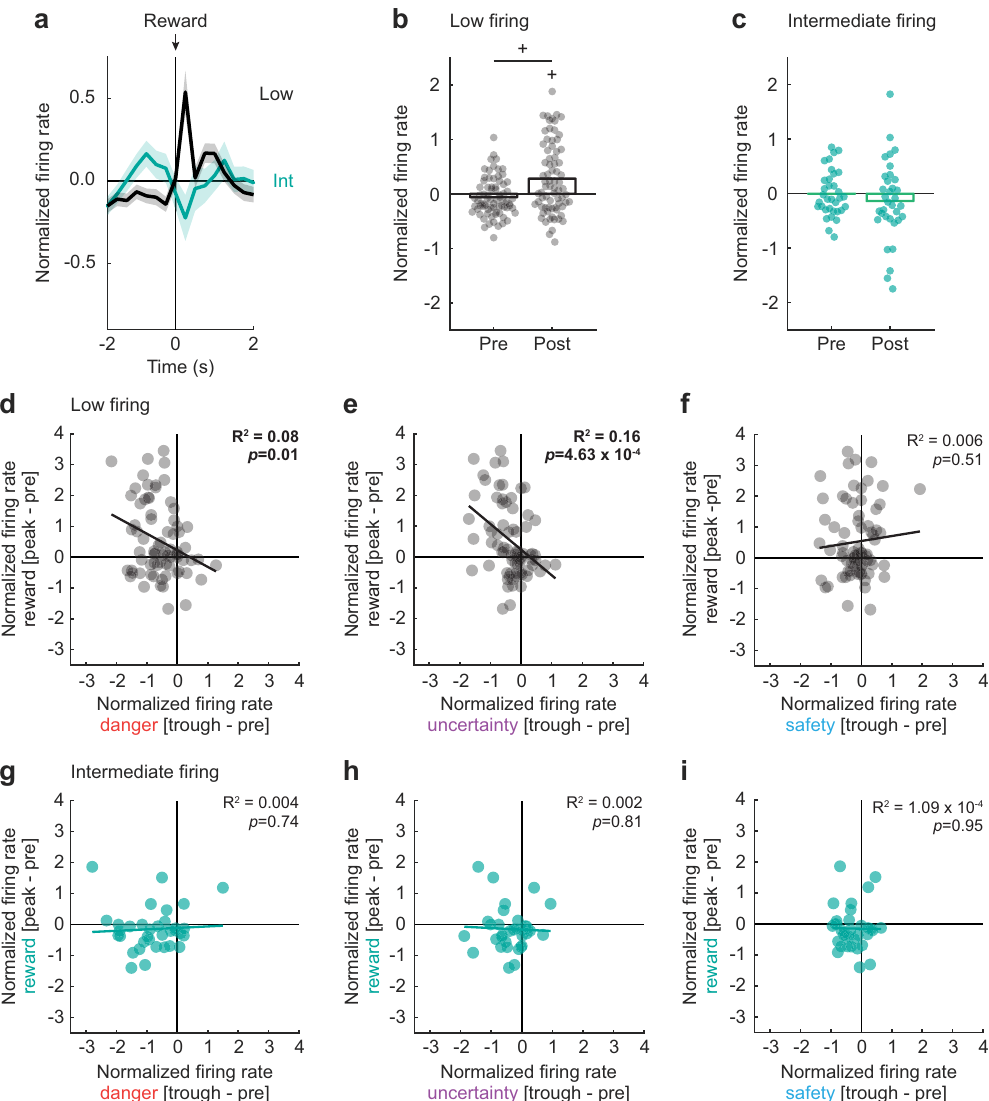
Fig. 5 Low fi ring neurons show opposing responses to threat and reward. a Mean ± SEM normalized fi ring rate to reward is shown 2 s prior to and 2 s after reward delivery (advancement of pellet dispenser) for the Low ( n = 74, black) and Intermediate ( n = 34, turquoise) fi ring neurons. Reward delivery is indicated by black arrow. SEM is indicated by shading. b Mean (bar) and individual (data points), normalized fi ring rate for Low fi ring neurons are shown during 500 ms interval prior (pre) to and 500 ms interval after (post) reward delivery. c Identical graph made for the Intermediate fi ring neurons, as in b . d Mean normalized fi ring rate to reward (250 ms prior to reward delivery to 250 ms following reward delivery, [peak - pre]) vs. danger (the second 250 ms of cue, [trough - pre], red) is plotted for Low fi ring neurons (black). e , f Mean normalized fi ring rate to e reward vs. uncertainty (purple) and f reward vs. safety (blue) is plotted for Low fi ring neurons, as in d . Trendline, the square of the Pearson correlation coef fi cient ( R 2 ) and associated p value ( p ) are shown for each graph. g – i Mean normalized fi ring rate to g reward vs. danger, h reward vs. uncertainty, and i reward vs. safety for Intermediate fi ring neurons (turquoise), as in d – f . + 95% bootstrap con fi dence interval for differential reward fi ring does not contain zero. + 95% bootstrap con fi dence interval for normalized fi ring rate does not contain zero. during late cue (0.50: M = 0.38, 95% CI [0.21, 0.54]; FO: M = 0.75 beta coef fi cients revealed an assignment × regressor interac- 0.19, 95% CI [0.08, 0.30]) and delay (0.50: M = 0.43, 95% CI tion ( F 1,129 = 3.92, p = 0.05, η p 2 = 0.03, op = 0.50). [0.26, 0.61]; FO: M = 0.17, 95% CI [0.05, 0.29]; Fig. 6d). Relative Early signaling of elevated relative threat gave way to joint threat and fear output beta coef fi cients differ from one another signaling of relative threat and fear output until shock delivery (Fig. 6c). ANOVA for beta coef fi cients [factors: regressor (0.50 assignment and fear output) and interval (1 s bins from 2 s prior to cue onset → 2 s following cue offset)] found a main effect of regressor ( F 1,128 = 6.29, p = 0.013, η p 2 = 0.05, op = 0.70) and a regressor × interval interaction ( F 13,1664 = 2.15, p = 0.01, η p 2 = Cue-excited neurons increase fi ring to reward . We examined 0.02, op = 0.96). Beta coef fi cients exceeding zero were observed for relative threat (assignment = 0.50) at cue onset ( M = 0.59, reward-related fi ring, time locked to the pellet dispenser advance, 95% CI [0.41, 0.76]), as well as relative threat and fear output to determine if cue-excited neurons speci fi cally signaled threat or COMMUNICATIONS BIOLOGY| (2021) 4:43